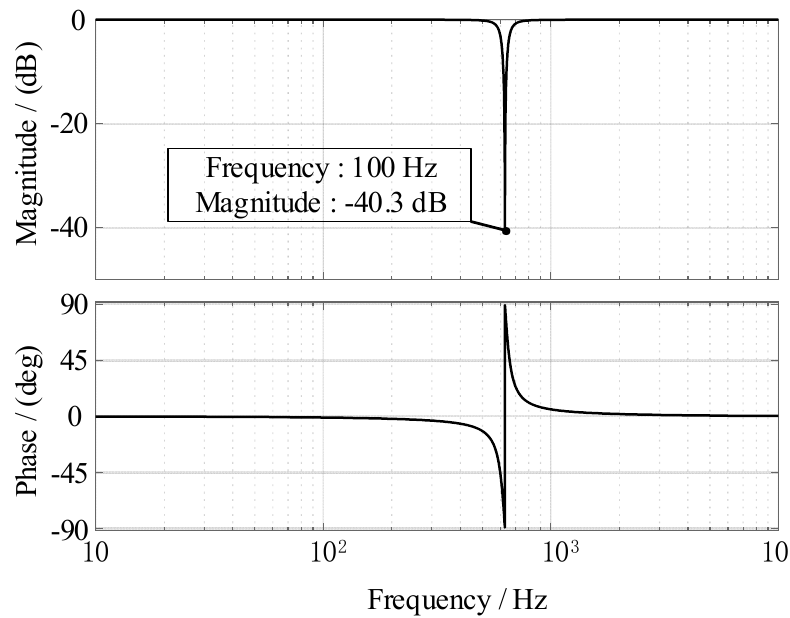
Figure 4. Standard LMS algorithm closed-loop transfer function bode diagram.